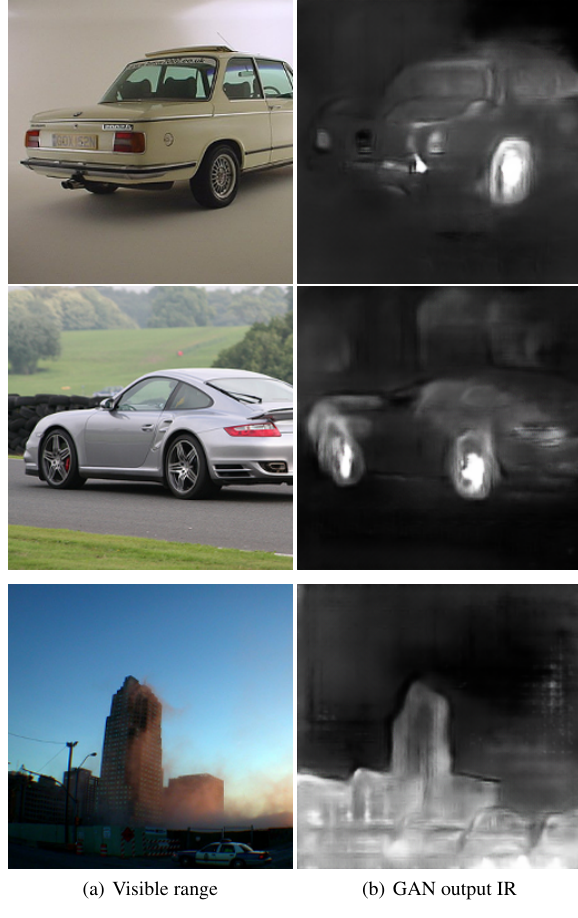
Figure 7. Examples of generated images